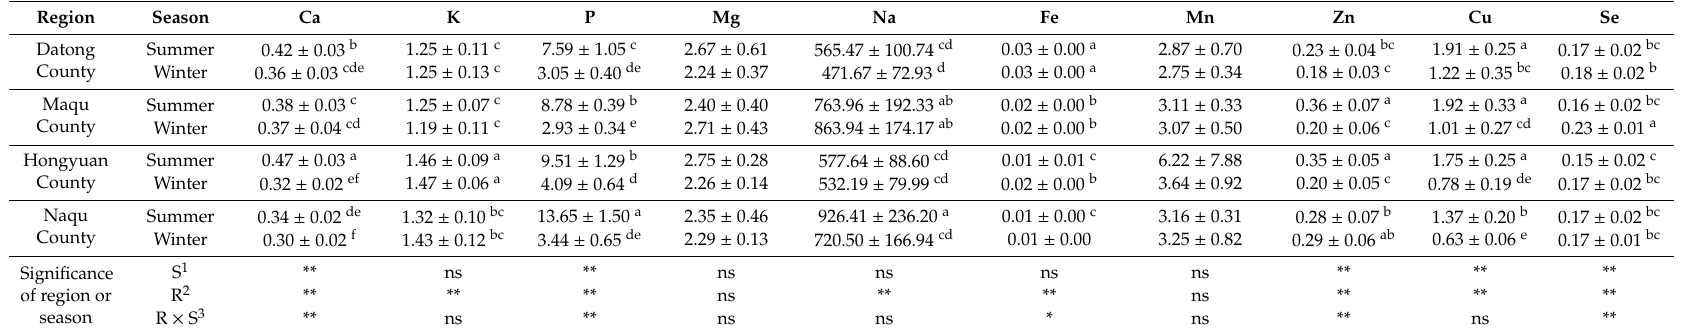
Table 6. Transfer factor (TF) in yak / soil (mean ± SE).